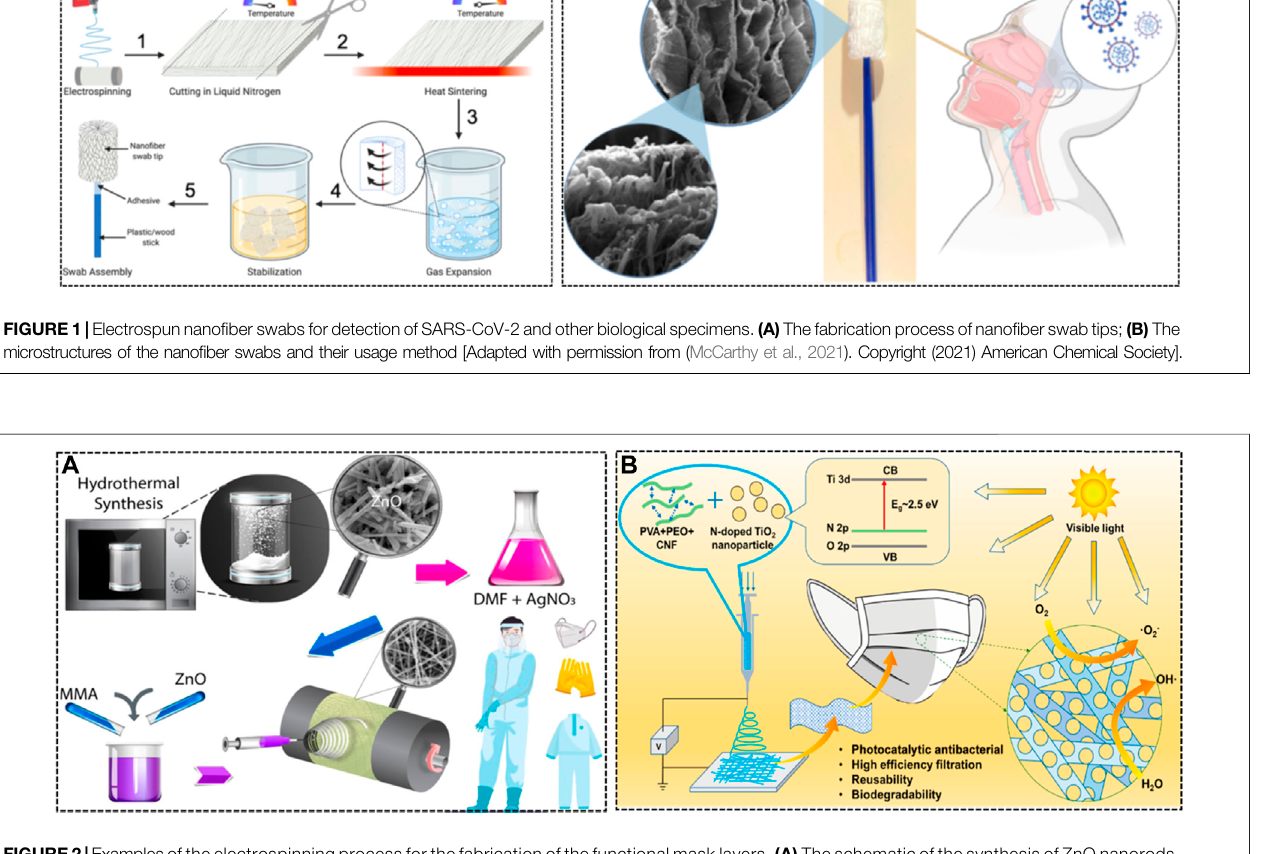
FIGURE2| Examplesof the electrospinning process for the fabrication of the functional mask layers. (A) The schematic of the synthesis of ZnO nanorods, preparation of the electrospinning solution of PMMA and ZnO nanorods with in situ generated AgNPs, and fabrication of the PMMA/ZnO-Ag nano fi bers for further PPE usage [Adapted with permission from (Karagoz et al., 2021). Copyright (2021) American Chemical Society]. (B) The illustration of the incorporated N-doped TiO 2 nanoparticles into the PVA, PEO, CNF mixture for electrospinning to engineer photocatalytic antiviral face masks [Adapted with permission from (Li Q. et al., 2021). Copyright (2021) American Chemical